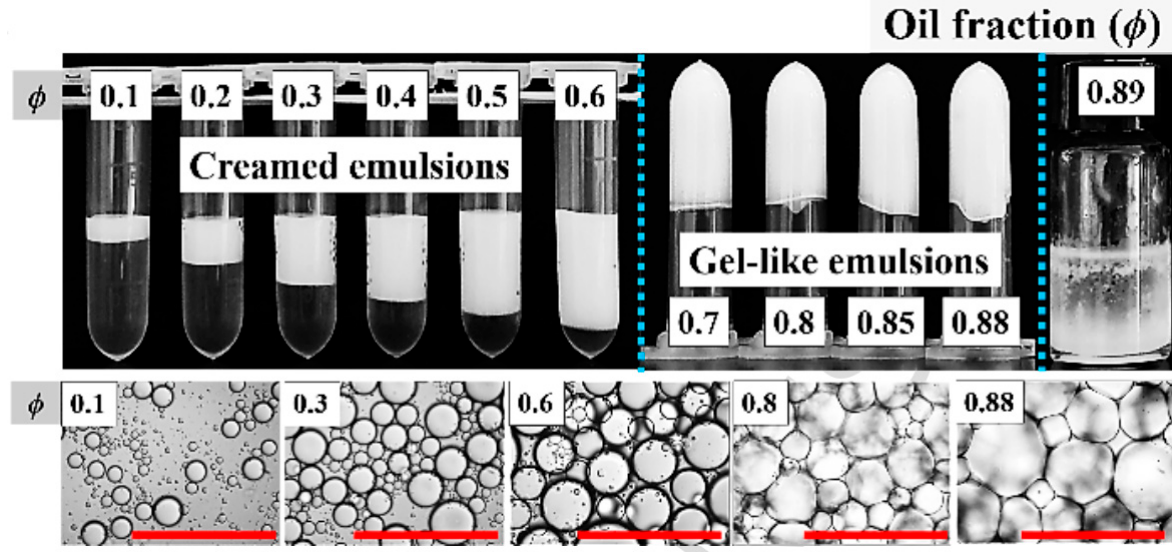
Figure 3. Apparent and microscopic characteristics of Pickering emulsions prepared with different volume fractions of oil phase. Adapted from [40] with permission from Elsevier Ltd., 2023.